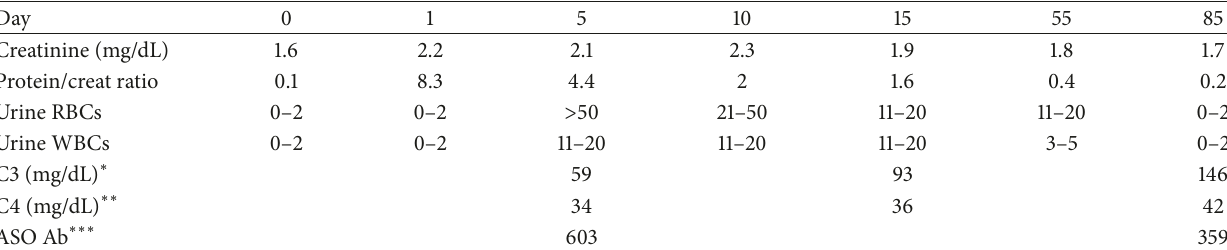
Table 1: Laboratory parameters during clinical course.